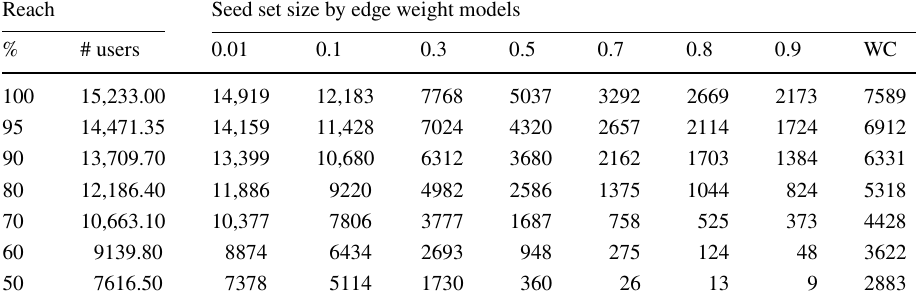
Table 6 HepPh expected Seed Set Sizes k ∗ p according to the reach